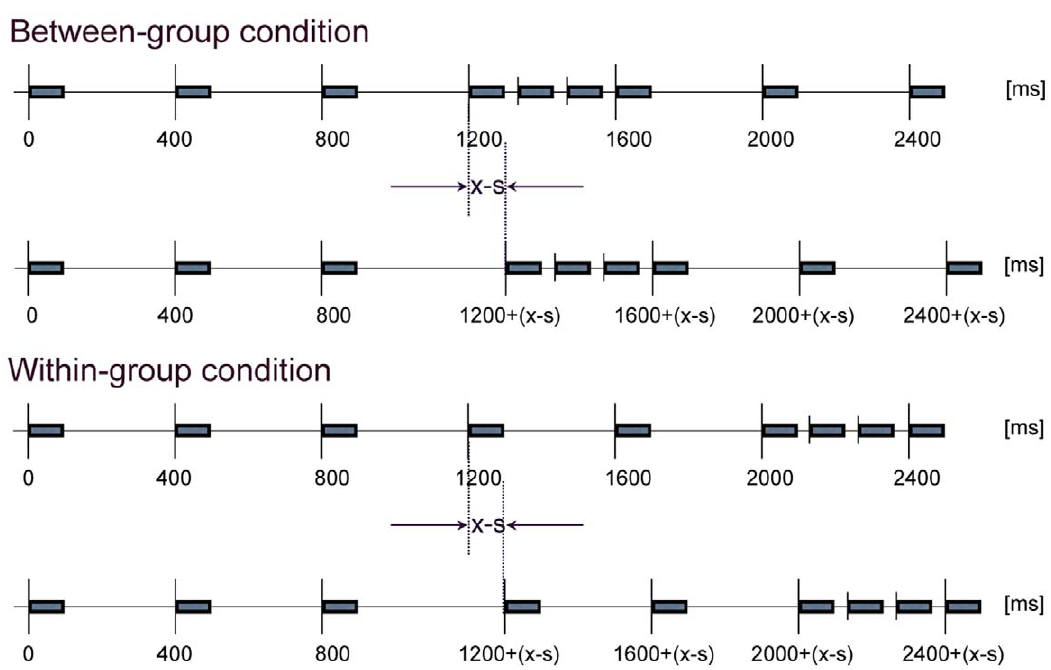
Figure 1. Temporal pattern of tone sequences for the between -group and within -group conditions. Top-diagrams of each condition indicate the standard rhythm (SR). Bottom-diagrams of each condition indicate the comparison rhythm (CR). x=deviant temporal interval, s=standard temporal interval.